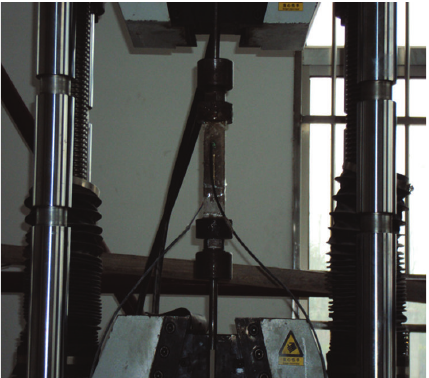
Figure 7: Picture of test setup for direct tension